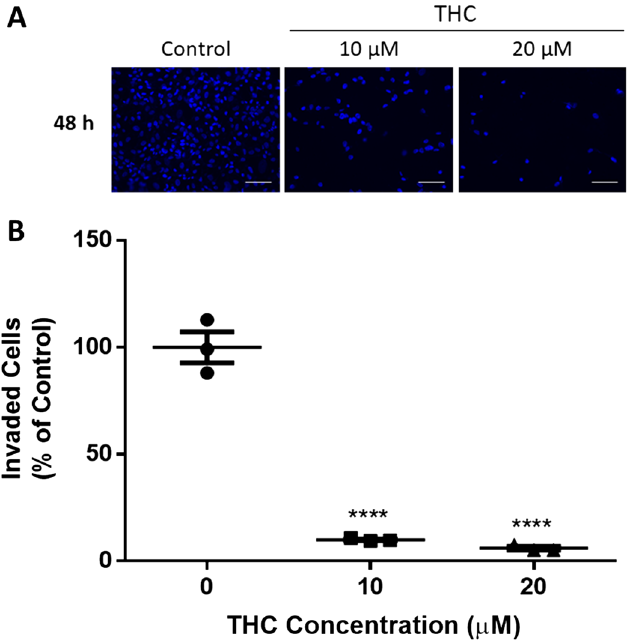
Figure 1. THC reduces HTR8/SVneo cell invasion. HTR8/SVneo cells were added to Matrigel-coated insert wells. The inserts were incubated for 48 h as described in “Methods”. (A) Representative immunofluorescent images of invaded HTR8/SVneo cells are shown, with the nuclei staining blue, magnification × 200 and scale bar indicates 100 µm (Nikon Eclipse Ti-E). (B) A summary histogram reporting the percentage of invaded cells relative to the vehicle control group (methanol), each data point is shown, the horizontal lines represent the means and the error bars represent SEM (n = 3). Significant differences were determined by a one-way ANOVA, followed by a Bonferroni post hoc test. **** P < 0.0001 (B)